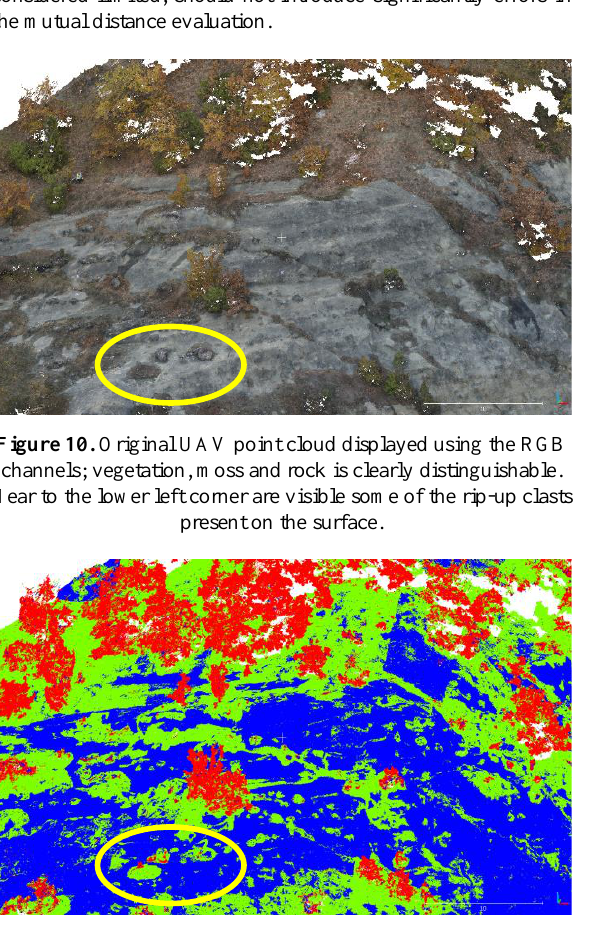
Figure 11. Classify UAV point cloud displayed using typological labels (blue for the bare rock, green for undergrowth, and red for high vegetation. Due to their shape, rip-up clasts were classified as undergrowth instead as